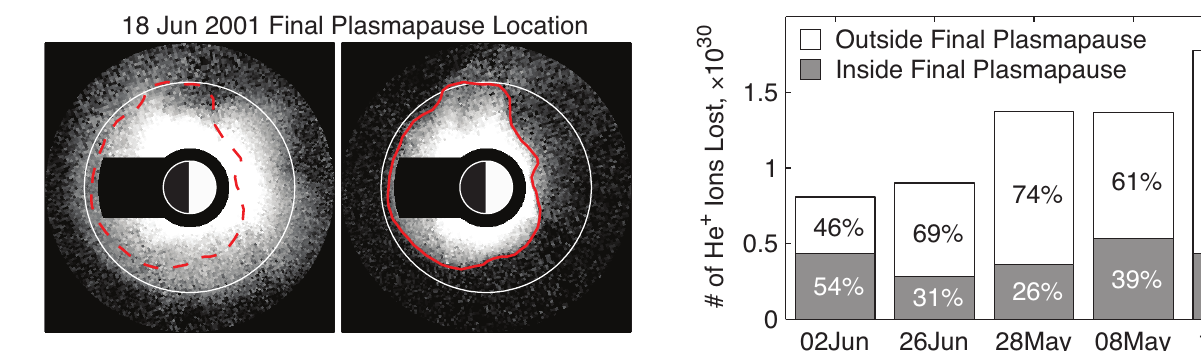
Fig. 6. The total number of He + ions removed from the plasma- sphere is broken down by the estimated amount lost inside versus outside the new plasmapause boundary. For example on 18 June 2001, 76% of the plasma loss occurred outside the new plasma- pause